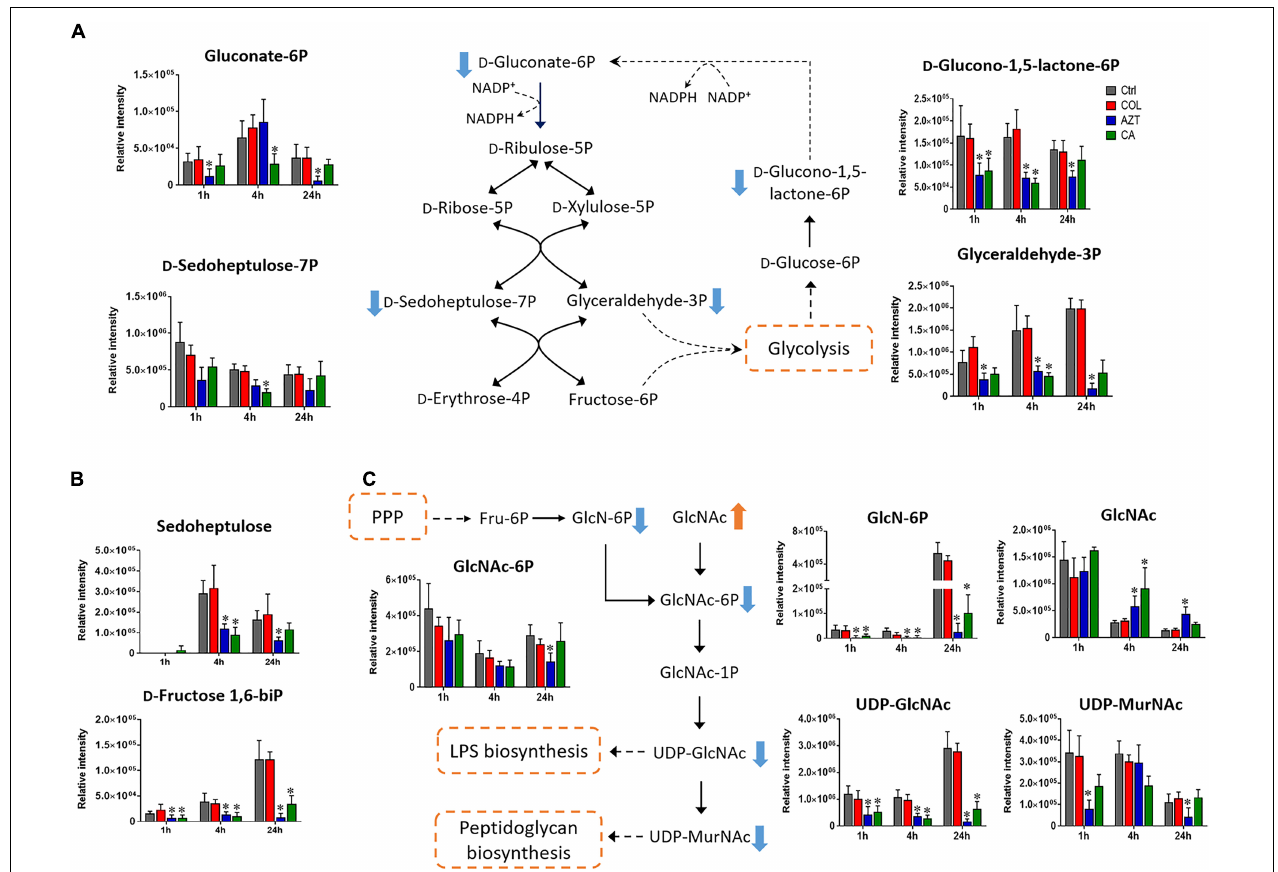
FIGURE 5 | Metabolic changes in (A) pentose phosphate pathway (PPP), (B) metabolites associated with PPP and carbon fixation, and (C) amino sugar metabolism in A. baumannii AB090342 after the treatment with colistin (COL, red), aztreonam (AZT, blue) and the combination (CA, green) compared to untreated control (Ctrl, gray) at 1, 4, and 24 h. The pathway flow charts were adapted from KEGG Pathway (http://www.genome.jp/kegg/pathway.html) with reference to Escherichia coli K-12. Orange and blue arrows indicate that the metabolites were significantly increased and decreased, respectively. ∗ FDR < 0.05, p < 0.05 and log 2 FC ≥ 1 or ≤ –1 (one-way